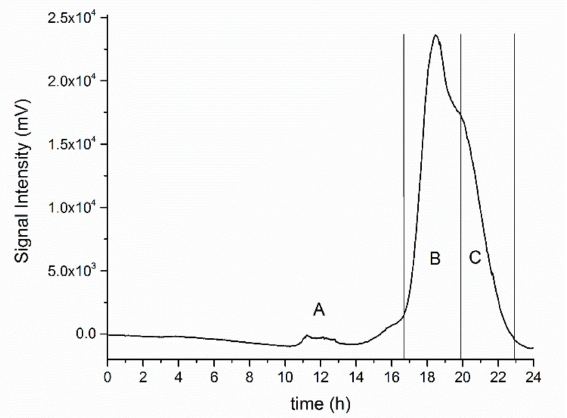
Figure 1. Elution profile on a Sephacryl S-300 column of the polysaccharide obtained from the culture filtrate of T. versicolor : bars indicate fractions, which were pooled together to give the sample polysaccharide (PLS)-B and PLS-C.